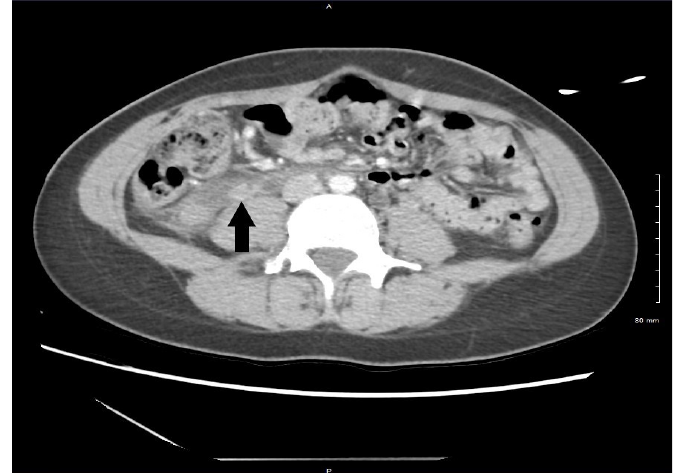
Image 2. Contrast-enhanced axial computed tomography image showing hyperdense border and lumen corresponding to thrombosis along course of right ovarian vein (black